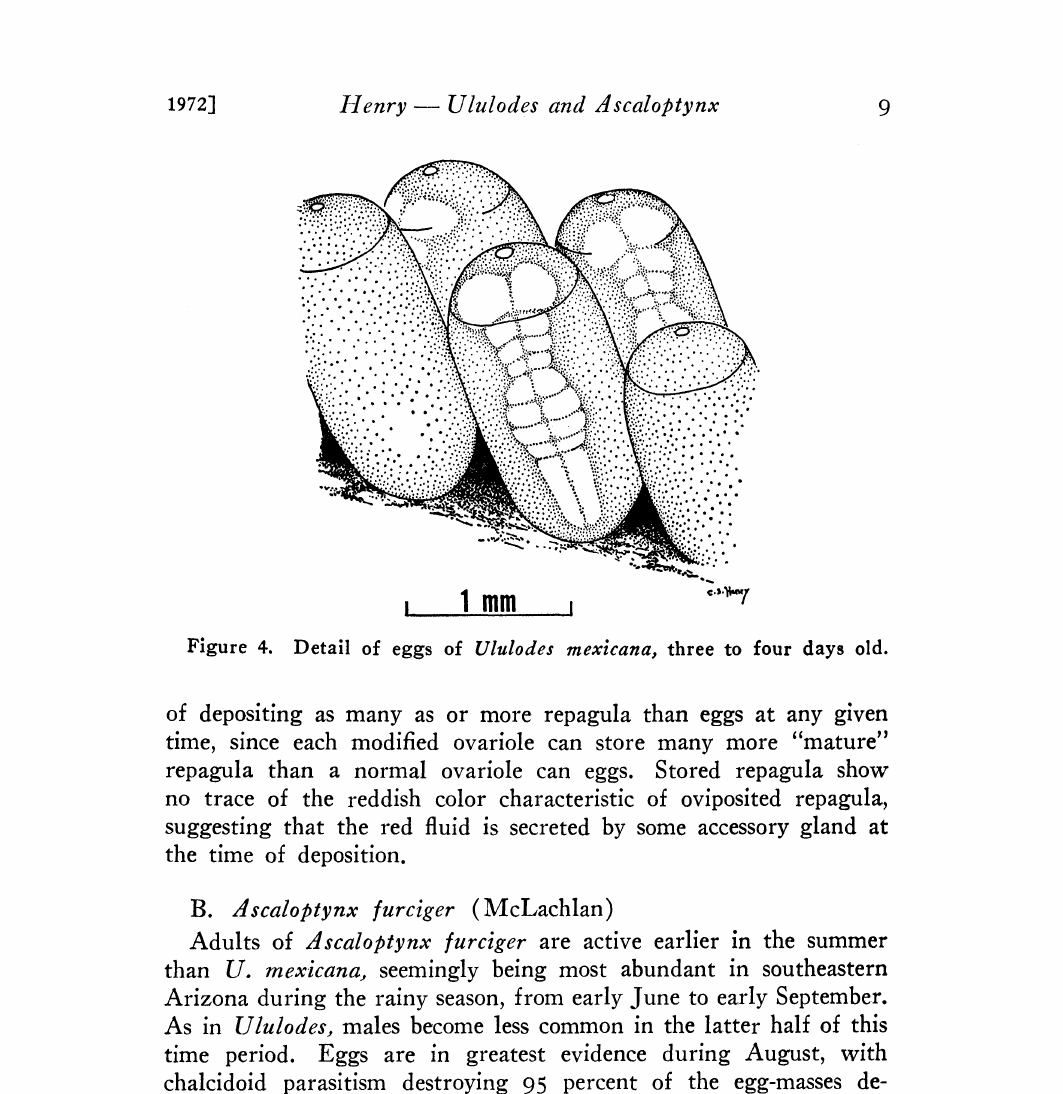
Figure 4. Detail of eggs of Ululodes mexicana, three to four days